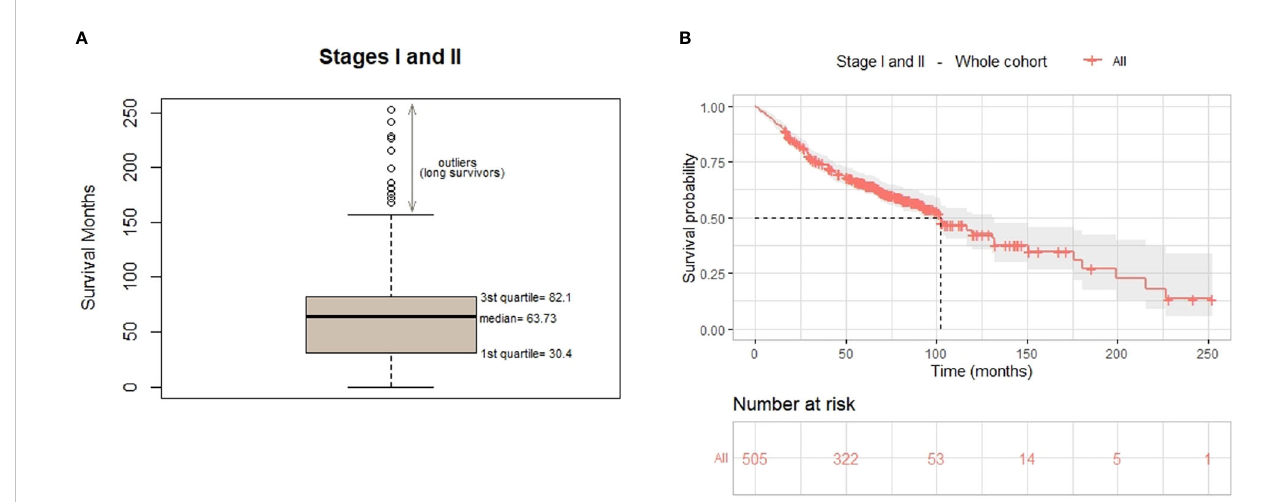
FIGURE 2 Overall survival of the whole cohort. (A) Box and whisker plot shows median AND quartiles survival (in months) and outliers. (B) OS curve for the 505 early stage patients estimated using the Kaplan-Meier